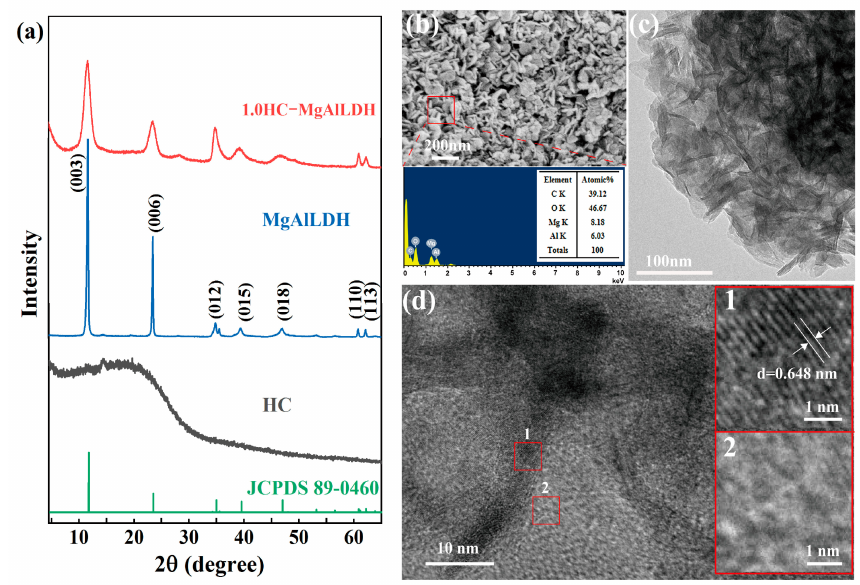
Figure 1. XRD patterns ( a ) of the synthesized HC, MgAlLDH and HC–MgAlLDH; SEM ( b) , TEM ( c ) and HRTEM ( d ) images of the HC–MgAlLDH, with the corresponding EDS spectrum in panel